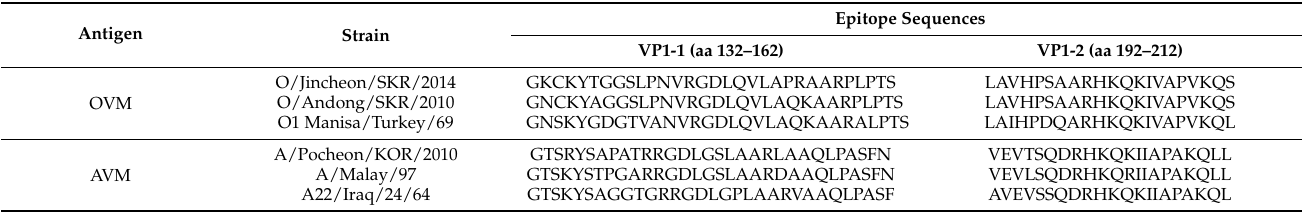
Table 1. FMDV VP1 epitope sequences used in OVM and AVM